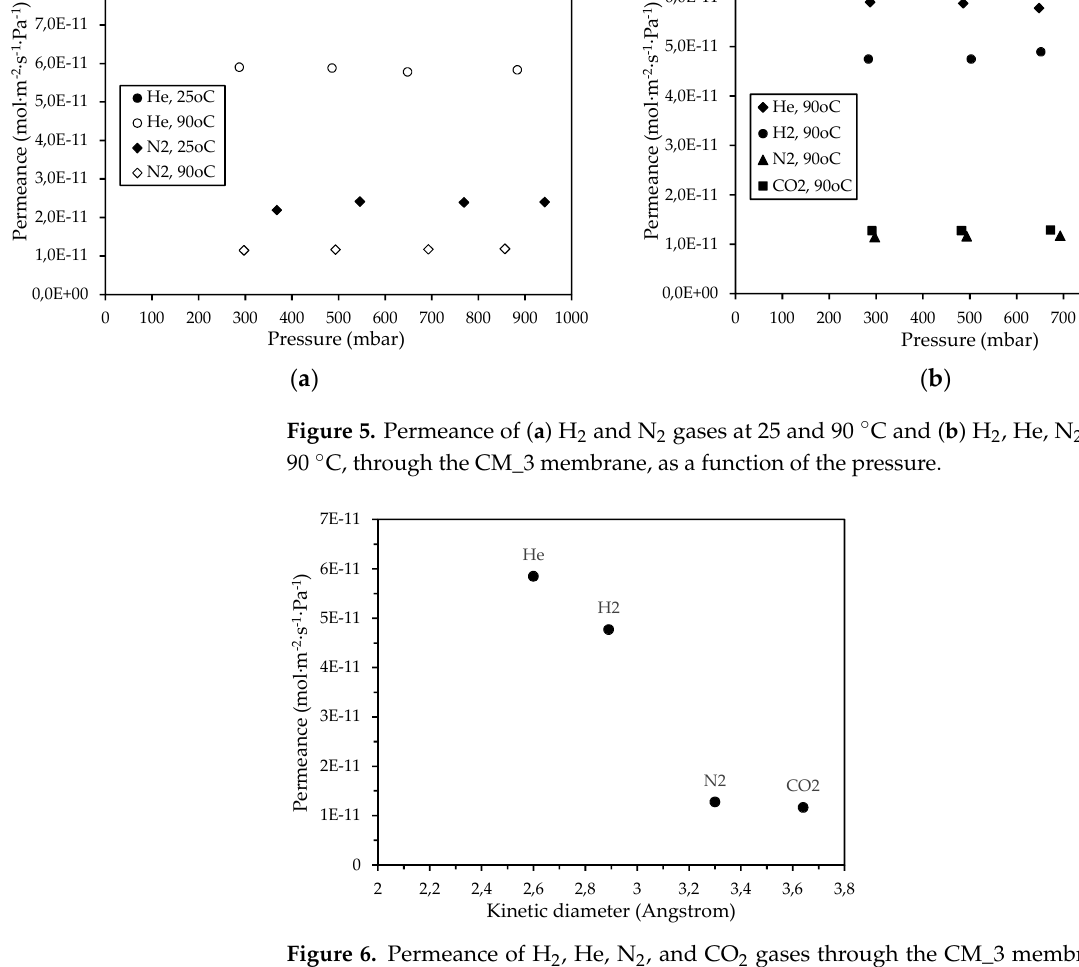
Figure 6. Permeance of H 2 , He, N 2 , and CO 2 gases through the CM_3 membrane at 90 ◦ C, with respect to their kinetic diameter.